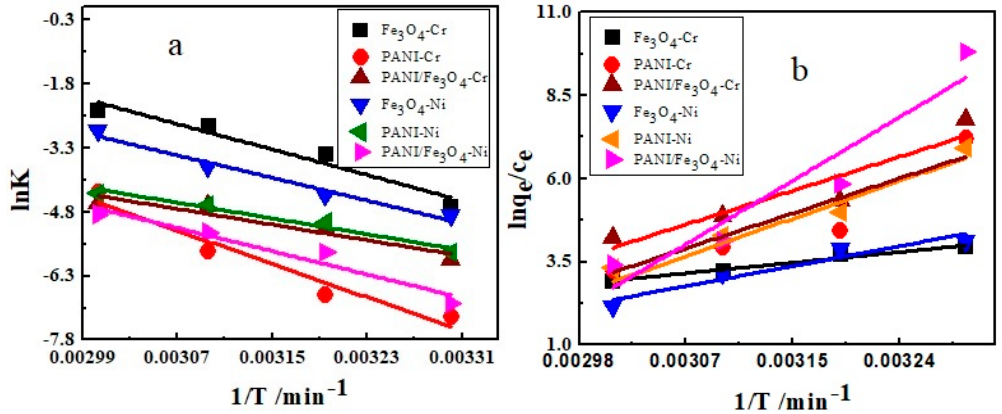
Figure 11. ( a ) Arrhenius plot and ( b ) Van’t ho ff plot of Cr(VI) and Ni(II) adsorption on Fe 3 O 4 , PANI, and PANI / Fe 3 O 4 composites. Table 3. Thermodynamic properties of adsorption.